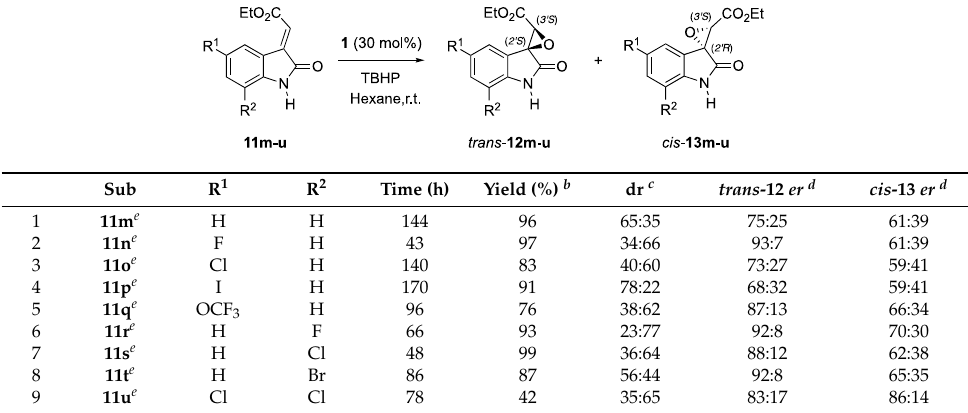
Table 3. Substrate scope of the organocatalytic epoxidation of α -ylideneoxindoles 11m – u featured with N -unprotected amide a .